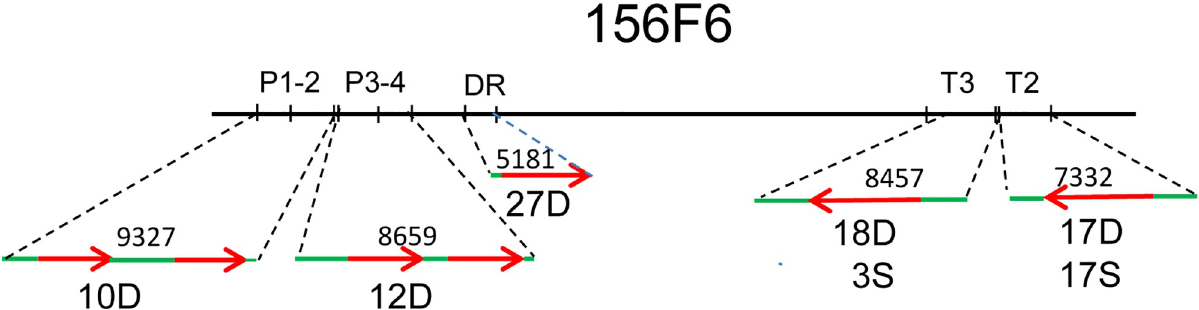
Fig 4. Schematic representation of the putative NLR resistance genes on the BAC clone 156F6 and the constructs used for transformation with the number of transgenic lines tested for virus resistance. Red arrows indicate the coding regions of the genes with introns and their direction of transcription. Green lines represent the non-coding regions. The genomic fragments were cloned in the binary vector pBIN19 and transformed into the PVY-sensitive potato cultivar ‘De´sire´e’ and ‘S440’. The size of the cloned fragments in bp was calculated from the 156F6 BAC clone sequence and is indicated above the red arrows and green lines. Symbols: P, phloem protein-coding gene; DR disease resistance gene; T, TMV resistance gene; D, ‘De´sire´e’; S, ‘S440’.